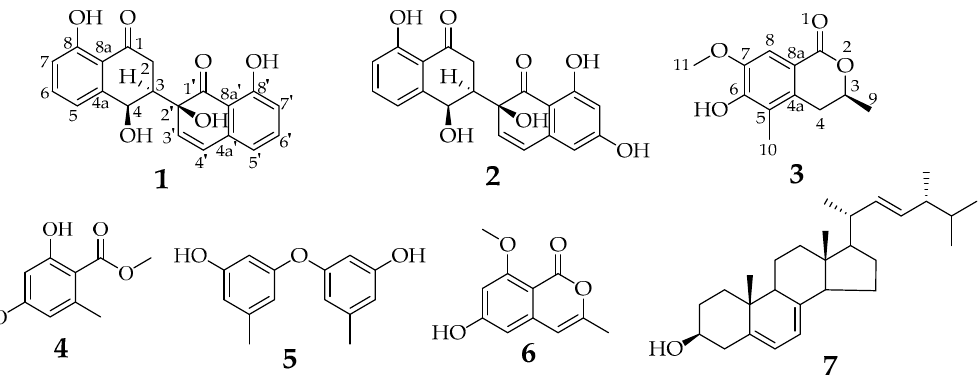
Figure 3. Chemical structures of compounds 1 – 7 isolated from Neohelicosporium griseum.